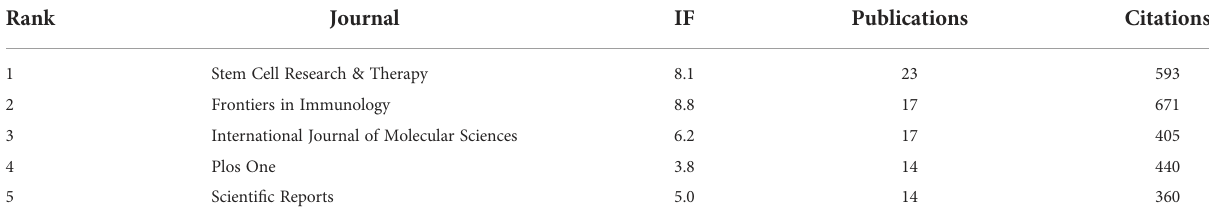
TABLE 3 Top 5 journals on research of MSCs and